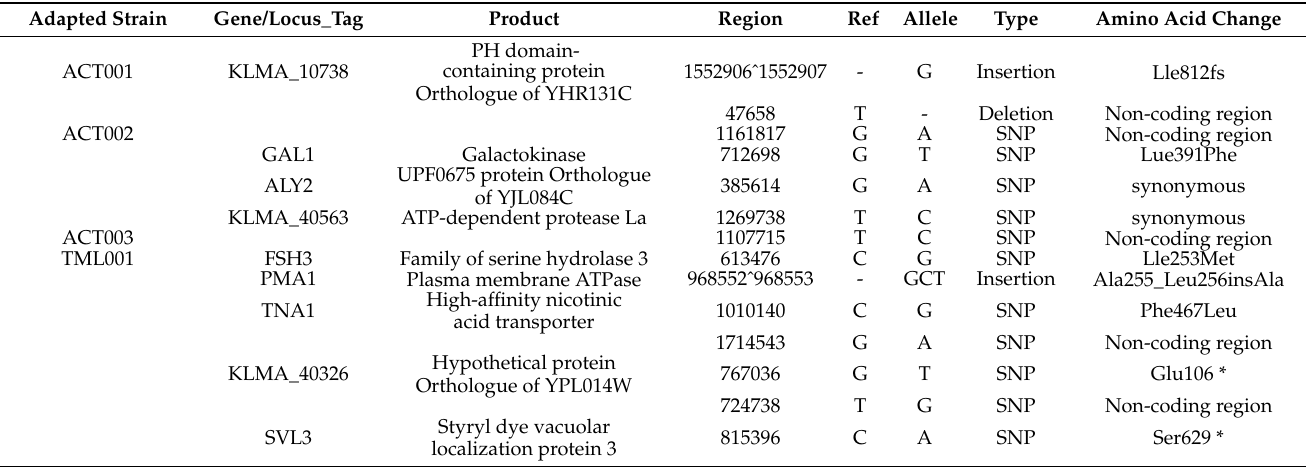
Table 2. Summary of mutations of adapted